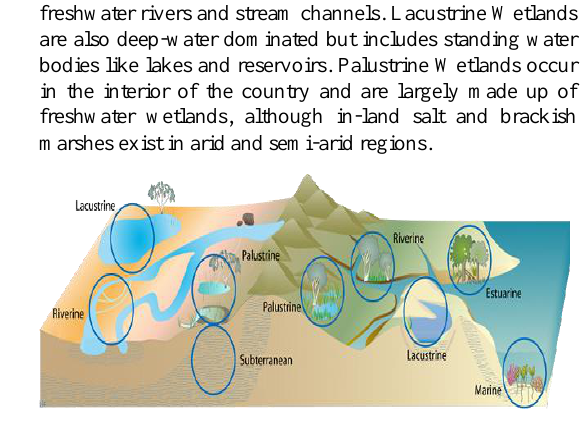
Fig.1 Graphic representation of wetland